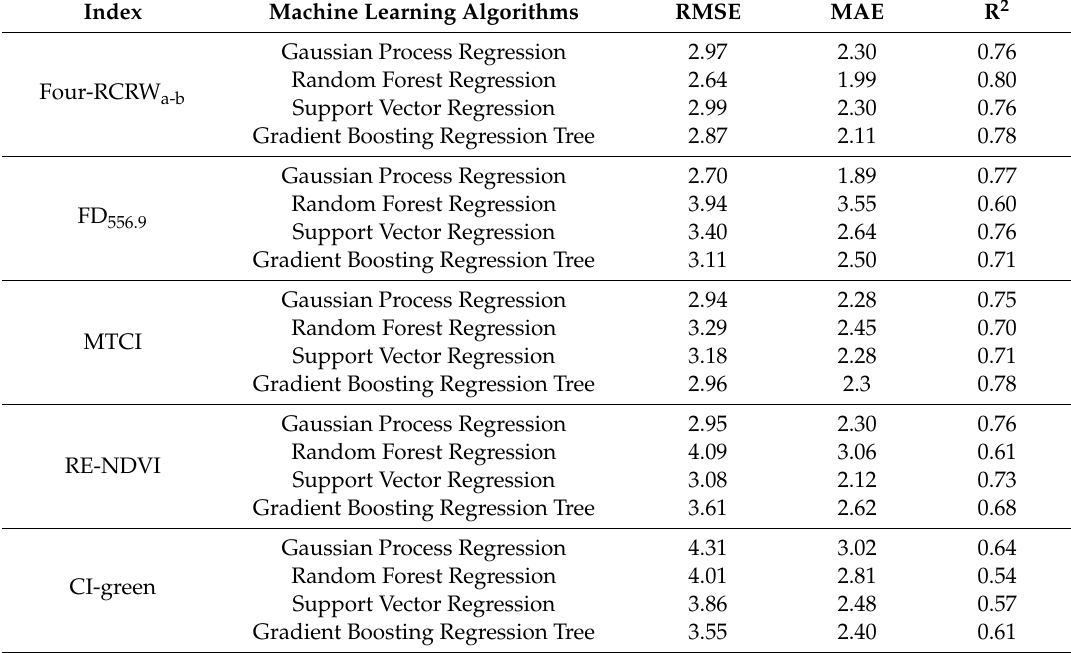
Table 4. Predicted results of some indexes using four machine learning algorithms and grid search-cross validation (GS-CV).